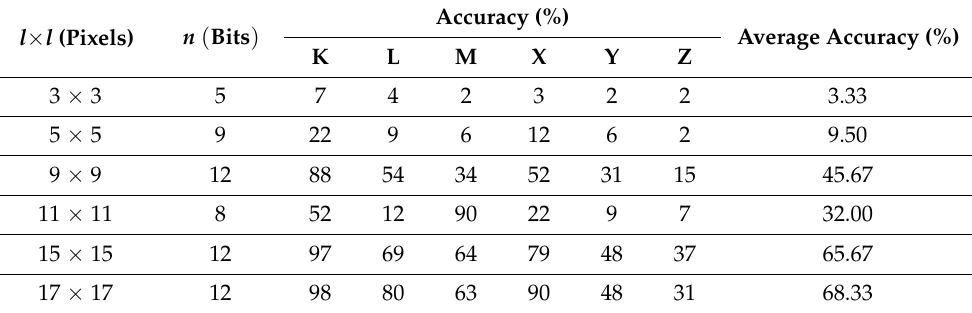
Table 3. Comparison of the results obtained using six BSIF configurations with occlusion by scarf.